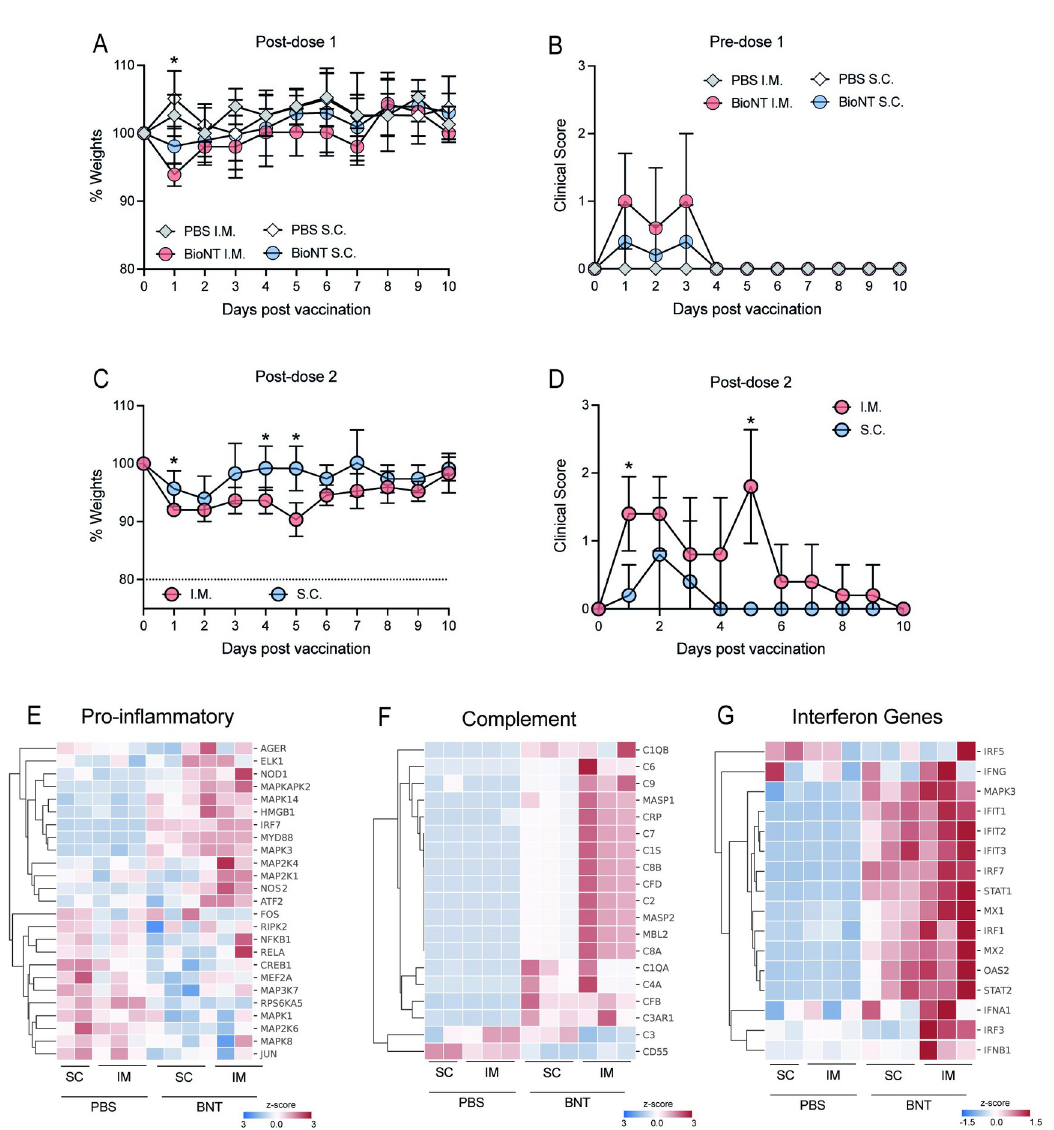
Fig 6. BNT162b2 vaccination via the s.c. route resulted in reduced weight loss, clinical scores and inflammation compared to vaccination via the conventional i.m. route. (A) Weights of animals assessed for the first 10 days postdose 1. (B) Clinical scores of animals assessed for the first 10 days postdose 1. (C) Weights of animals assessed for the first 10 days postdose 2. (D) Clinical scores of animals assessed for the first 10 days postdose 2. (E–G) Expression of pro-inflammatory (E), complement (F) and IFN response (G) genes in whole blood presented as heatmap of z-scores. Data presented as means ± SD. In vivo experiments were conducted with a minimum of n = 5 per group, except for gene expression study with n = 3 per group. Unpaired Student t test was used for experiments comparing 2 groups. � P < 0.05. Data underlying this figure can be found in S1 Data. IFN, interferon; i.m., intramuscular; s.c., subcutaneous.